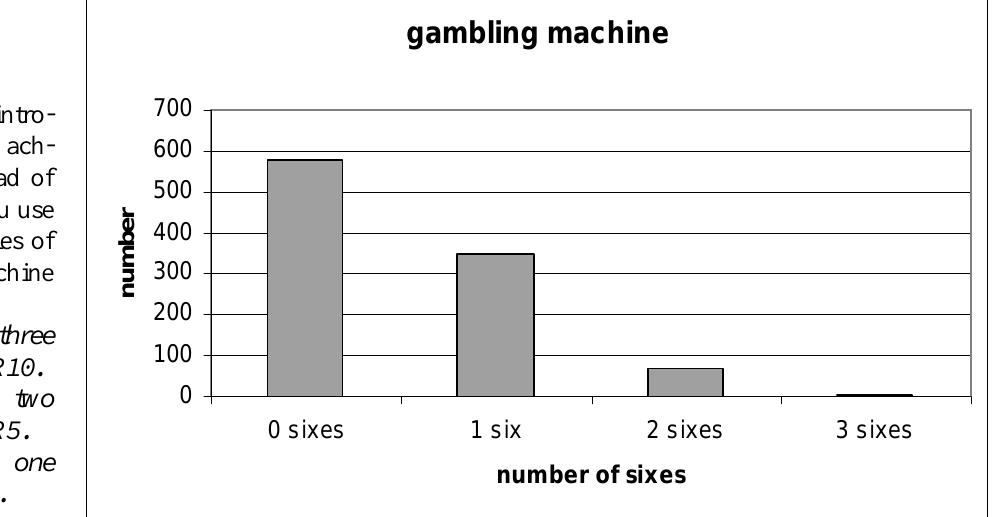
Figure 4. Gambling machine bar